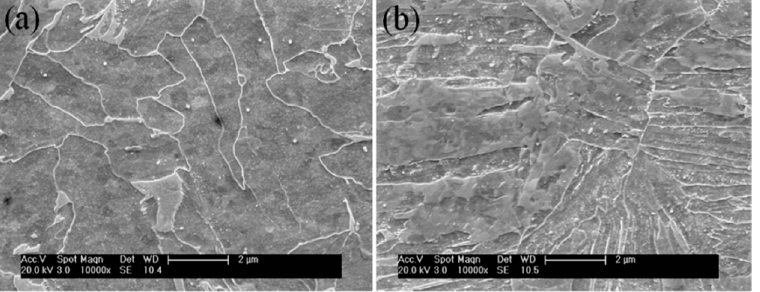
Figure 12. The microstructures of ( a ) weld and ( b ) HAZ. Reprinted with permission from ref. [108]. Copyright 2015, Elsevier.